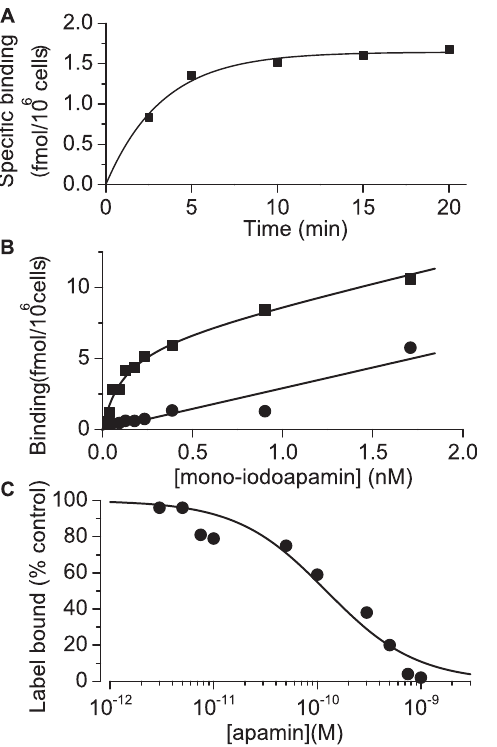
Figure 2. Binding of 125 I-apamin to K Ca 2.2. A Time course of 125 I- apamin binding to HEK 293 cells stably expressing K Ca 2.2. The y -axis shows specific binding of 125 I-apamin at times indicated on the x -axis. Each point represents the mean of triplicate observations from a single experiment. The data are fitted by a single exponential function (solid line) with an apparent rate constant of 0.3 6 0.03 min –1 . The mean rate constant from 3 separate experiments was 0.24 6 0.04 min –1 suggesting that binding reaches equilibrium well within 10 minutes. B Equilibrium N binding of 125 I-apamin to HEK 293 cells stably expressing K Ca 2.2. The ) binding in the presence of graph shows total ( & ) and non-specific ( label. Each point is the mean of triplicate observations from a single experiment. Combined data yielded estimates of K L and B max of 91 6 40 pM and 6.4 6 1.3 fmol/10 6 cells (n=3). Solid lines represent a linear fit (non-specific binding) or a fit using the modified Hill equation for B tot (see methods). C Inhibition of 125 I-mono-iodoapamin binding to K Ca 2.2 by unlabelled apamin. Each point is the mean of triplicate observations from a single experiment. Data were fitted to the Hill equation (solid line). Estimates of K L from saturation binding experiments were used to estimate K i as described in the methods section and the derived estimates are given in Table 1.